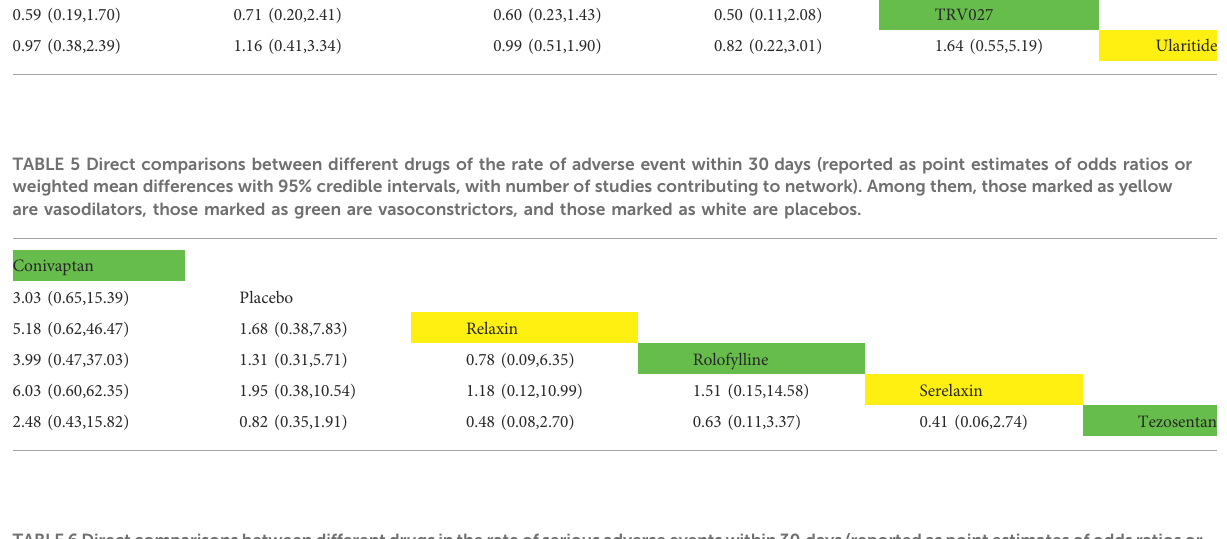
TABLE6Directcomparisonsbetweendifferentdrugsintherateofseriousadverseeventswithin30 days(reportedaspointestimatesofoddsratiosor weighted mean differences with 95% credible intervals, with number of studies contributing to network). Among them, those marked as yellow are vasodilators, those marked as green are vasoconstrictors, and those marked as white are